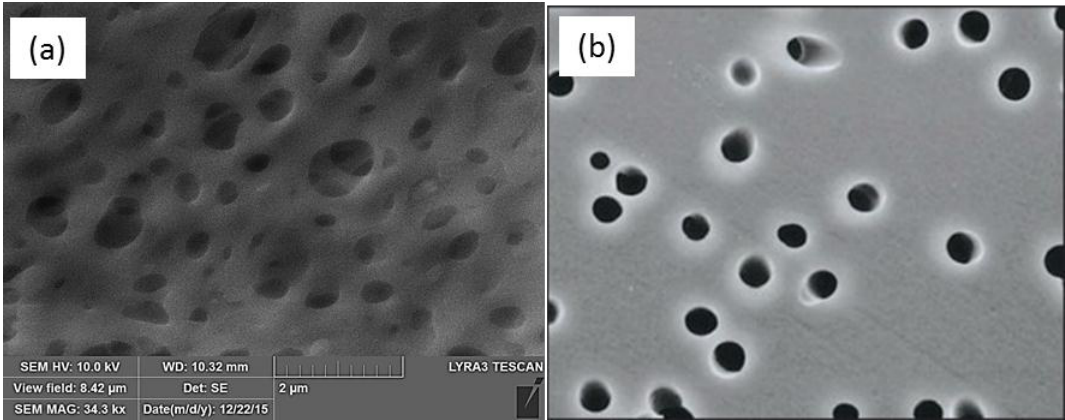
Figure 1. Microstructure of an ( a ) phase-inversion PES membrane and ( b ) track-etched membrane [1].